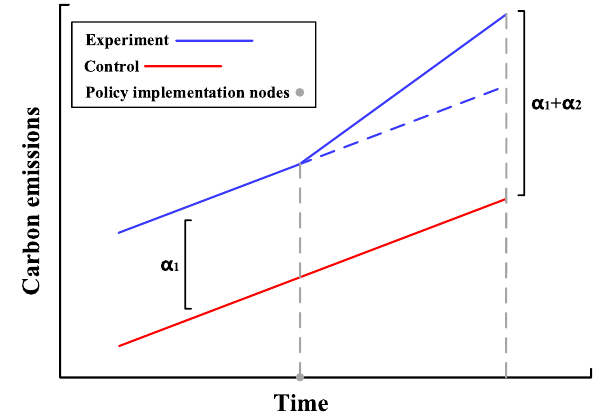
Fig. 2 Schematic diagram of differences-in-differences estimators. The experimental group (solid blue), the control group (solid red), and the policy implementation node (solid grey dots) are